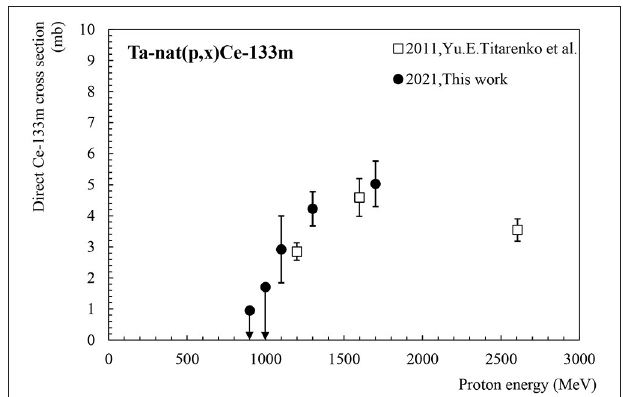
FIGURE 1 | Independent cross-section for Ce-133m production as a function of the proton beam